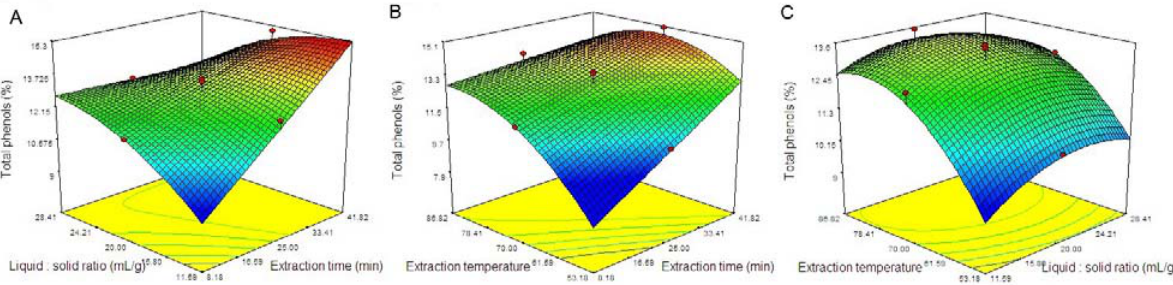
Figure 1. Response surface plots of the effect of ( A ) liquid:solid ratio and extraction